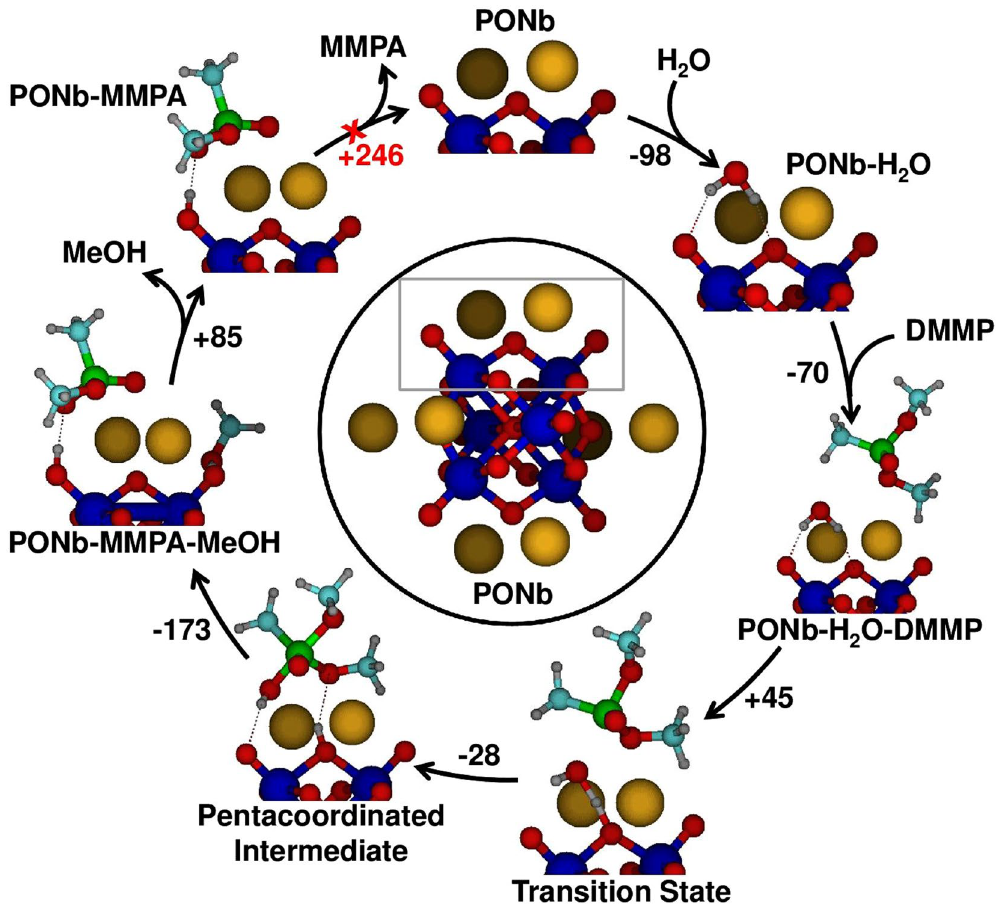
Figure 1. The minimum-energy reaction pathway for the hydrolysis of DMMP by Cs 8 [Nb 6 O 19 ]. For clarity, only the region of the PONb unit (outlined by a rectangle) interacting with the adsorbate is shown in the pathway. Energies are in kJ/mol. Color code: red (O), orange (Cs), blue (Nb), grey (H), green (P) and cyan